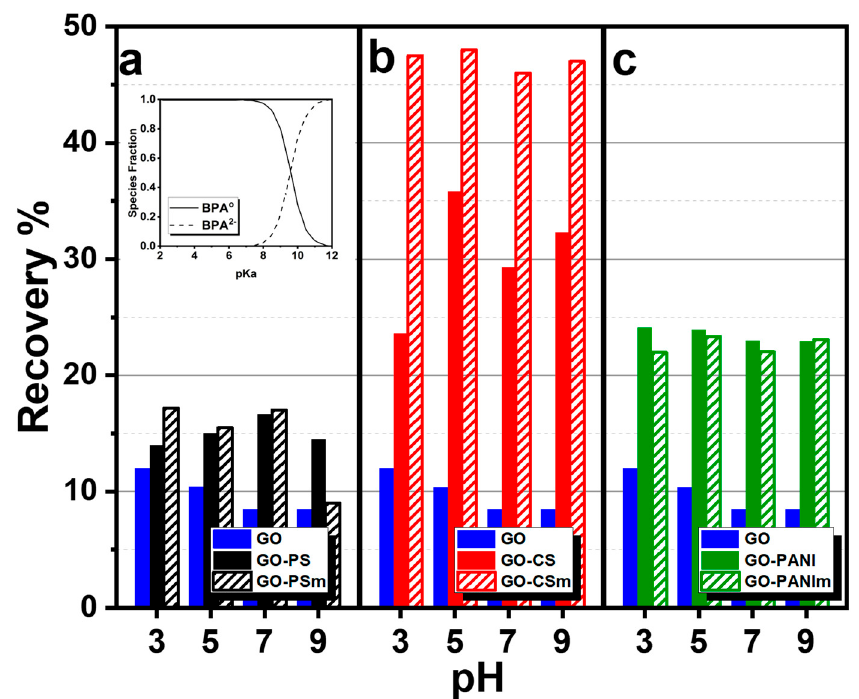
Figure 6. Effect of pH on adsorption of bisphenol–A (BPA) by ( a ) GO–PS and GO–PSm, ( b ) GO–CS and GO–CSm and ( c ) GO–PANI and GO–PANIm, and GO as reference; in the inset: the species distribution diagram for BPA [46,47].